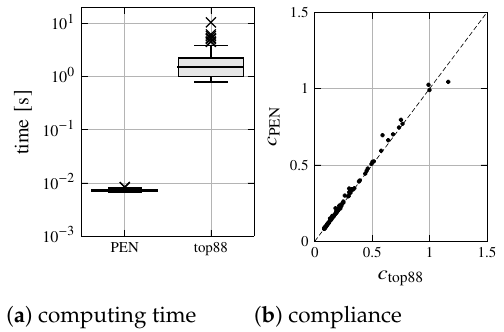
Figure 14. Computing time and compliance comparison. On average, the ANN-based TO can deliver almost the same result as the conven- tional method in about 7.3 ms, while the conventional topology optimizer according to Andreassen et al. [29] requires, on average, 1.9 s (and is, therefore, roughly 259 times slower); see Figure 14a. It can also be seen that the majority of geometries generated by PEN have a compliance that is close to the geometries generated by top88; see Figure 14b. In addition to the comparison of compliance and computing time, there are indicators that allow the comparison of geometries generated by ANN-based TO with geometries generated by conventional